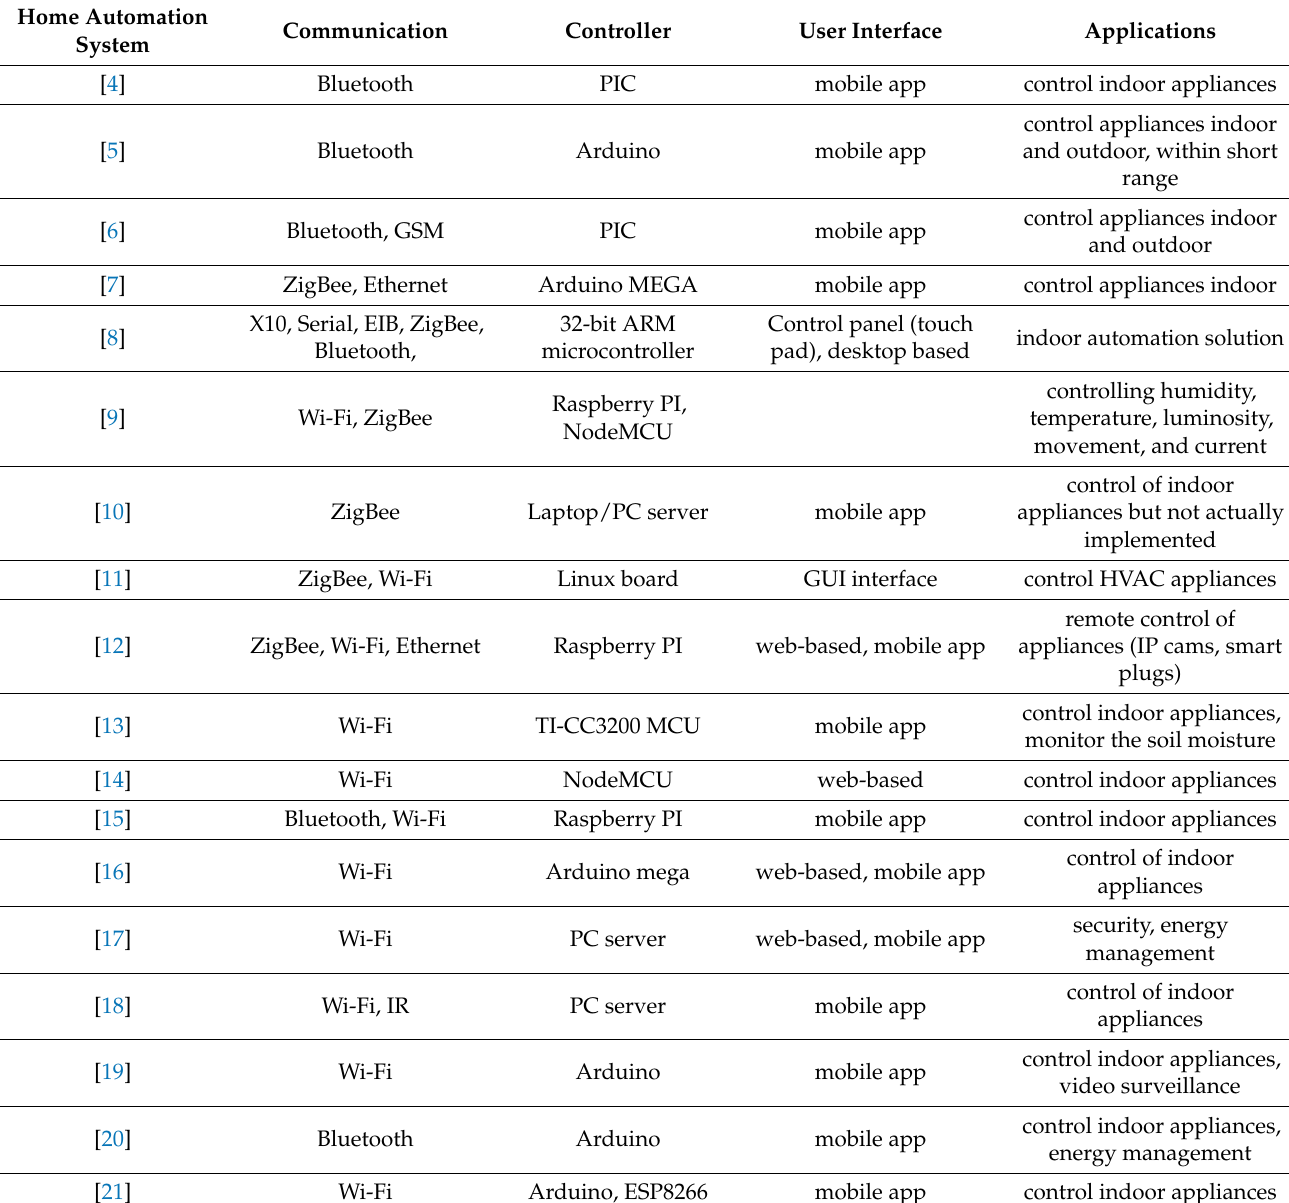
Table 1. Features comparison for home automation system published in the last 10